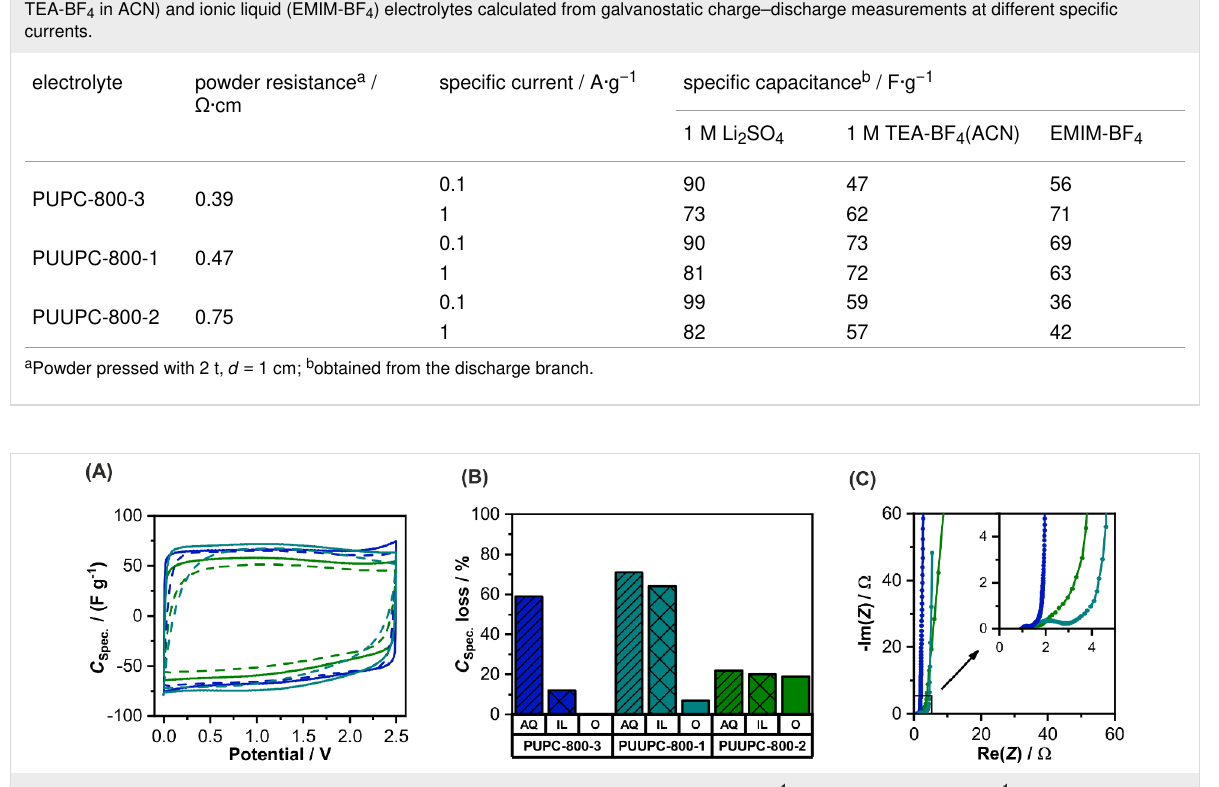
Figure 4: (A) Cyclic voltammogram measured in 1 M TEABF 4 (ACN) with a scan rate of 10 mV·s − 1 (solid lines) and 100 mV·s − 1 (dashed lines), (B) loss of the specific capacitance in three different electrolytes, and (C) Nyquist plot for the three samples PUPC-800-3 (blue), PUUPC-800-1 (cyan), and PUUPC-800-2